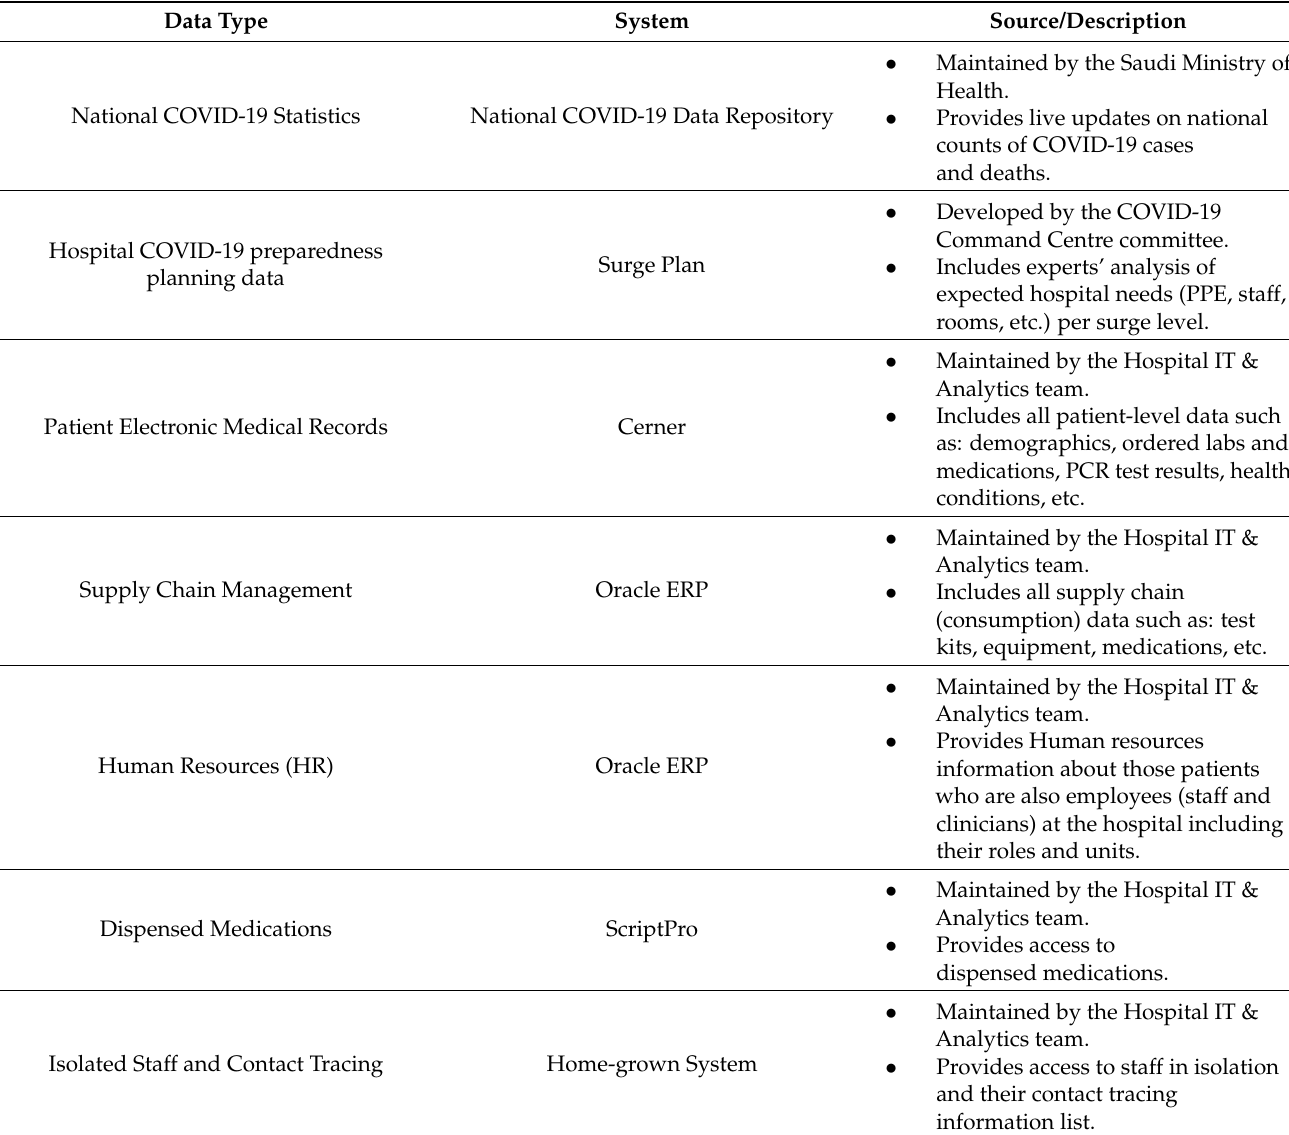
Table 1. Dashboard Data